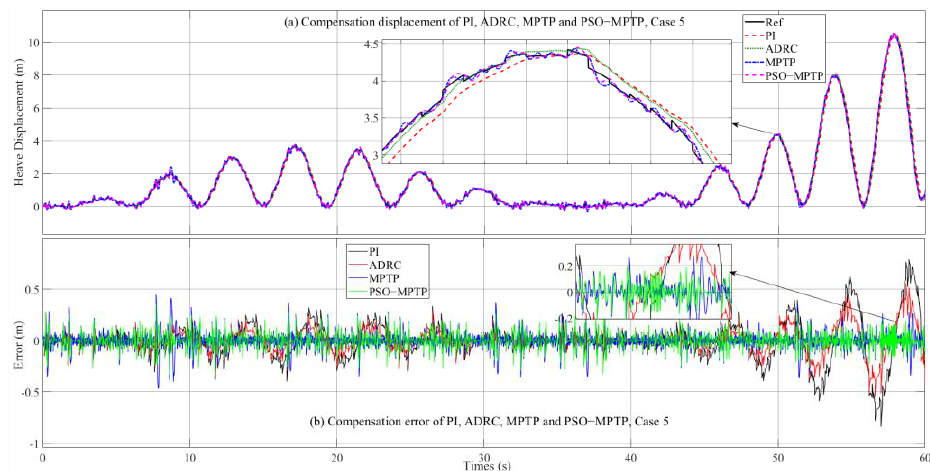
Figure 14. ( a ) Compensation displacement of PI, ADRC, MPTP, and PSO − MPTP, Case 5. ( b ) Com- pensation error of PI, ADRC, MPTP, and PSO − MPTP, Case 5.